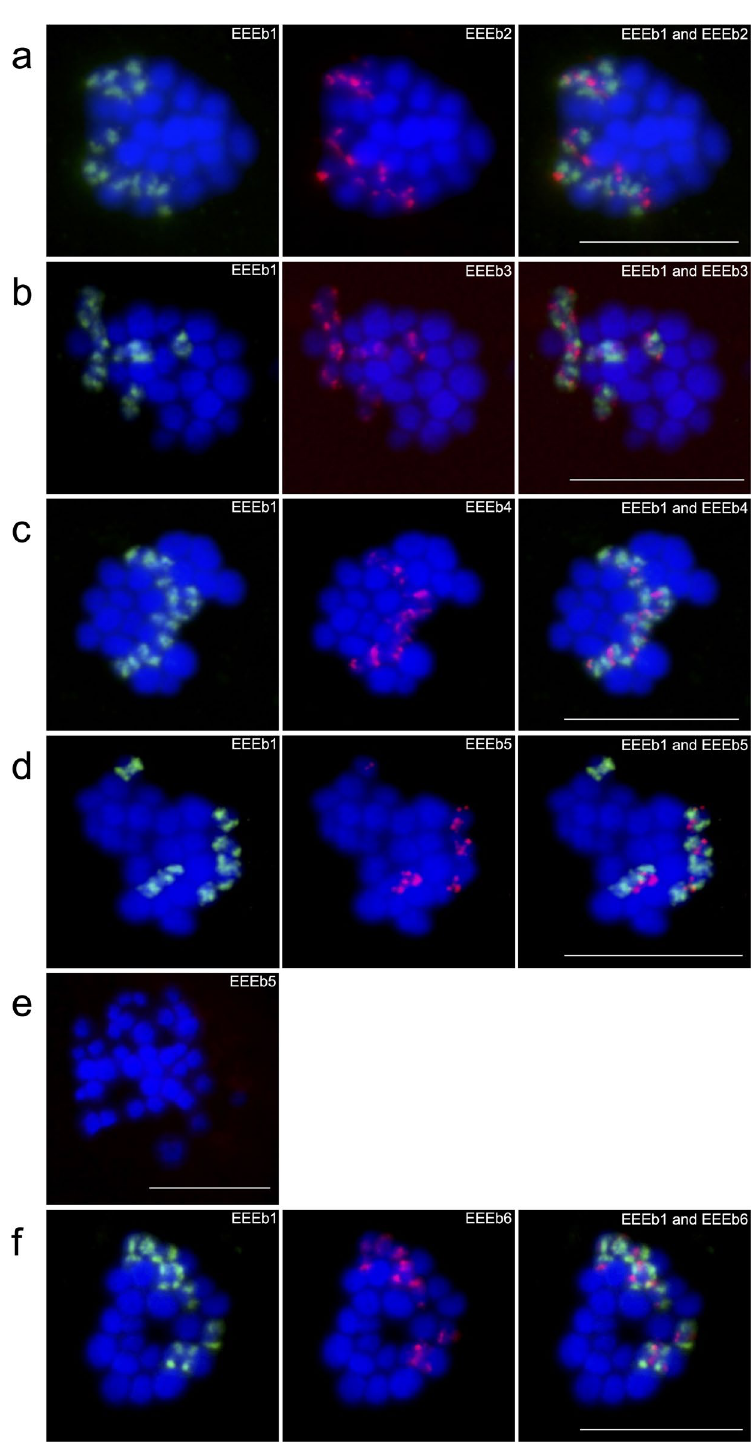
Figure 4. Chromosomal mapping of five eliminated DNA families in E. burgeri . Metaphase chromosomes from spermatocytes were hybridized using a digoxigenin-labeled EEEb1 probe (green) with biotin-labeled EEEb2 ( a ), EEEb3 ( b ), EEEb4 ( c ), EEEb5 ( d ), and EEEb6 ( f ) (red). The chromosomal localization of EEEb5 in somatic cells is shown in ( e ). Chromosomes were counterstained with Hoechst 33342 (blue). Scale bar = 5